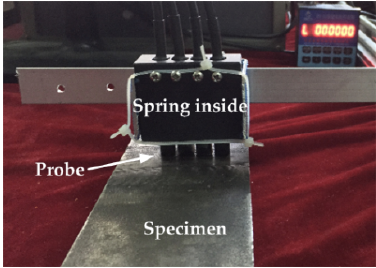
Figure 10. The structure with a spring inside to keep the probe in touch with the specimen surface, ensuring zero lift-off.